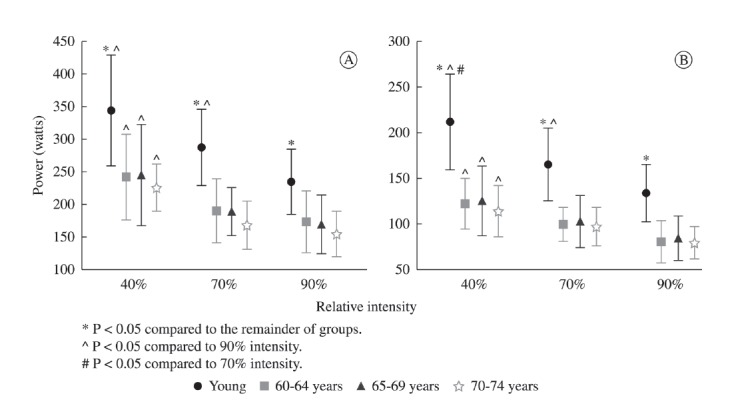
Mean and standard deviation of muscle power of the knee extensors (A),
and knee flexors (B) at the relative intensities of 40%, 70%, and 90% 1-RM
among the different age groups (young, 60-64, 65-69, and 70-74 years
old).